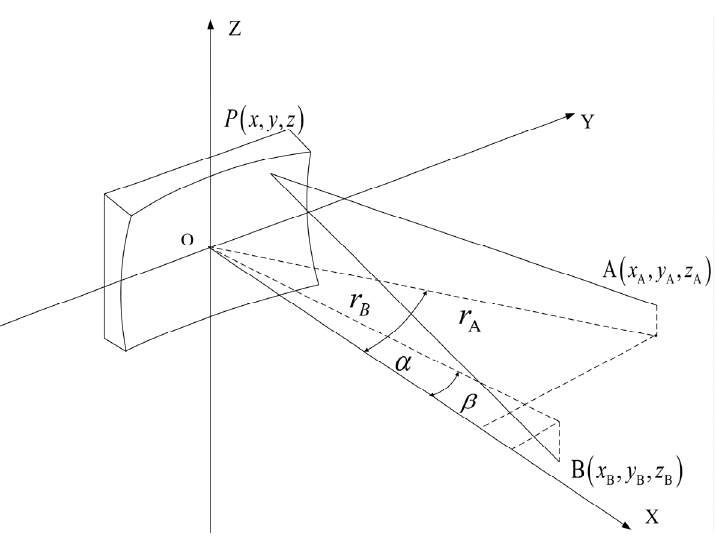
Figure 6. Schematic of the optical layout of concave grating.